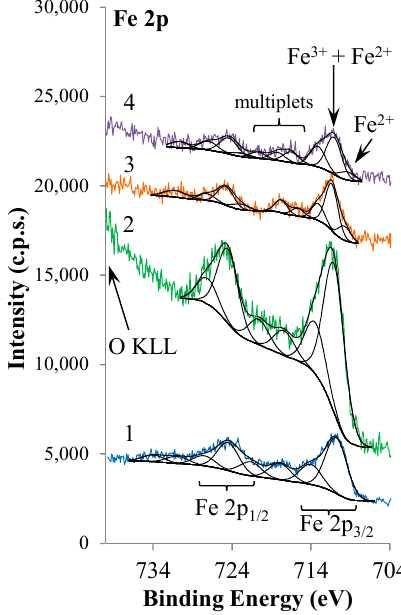
Figure 3. Fe 2p X-ray photoelectron spectroscopy (XPS) regions of 1 – 4 .